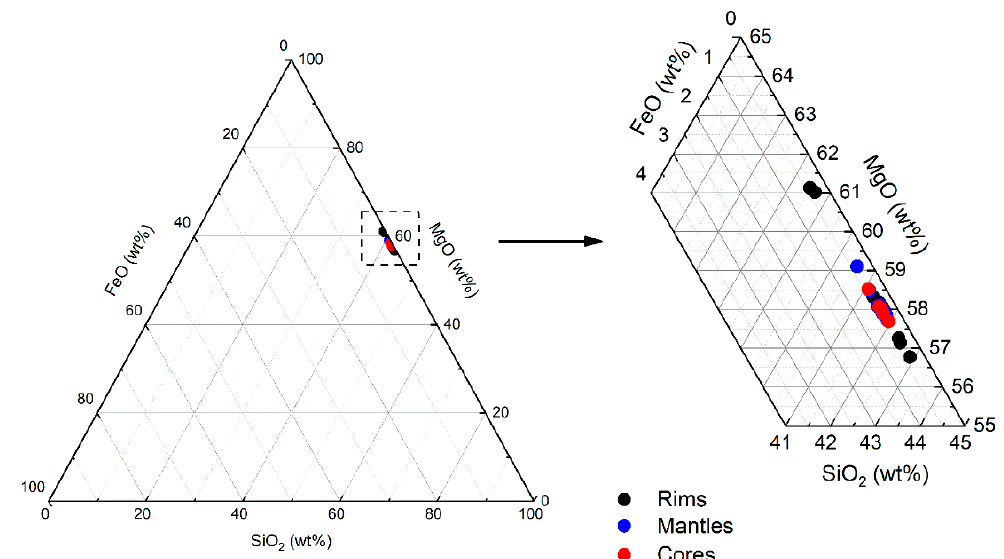
Figure 9. Compositions of the olivines in jianite, plotted in the SiO 2 -MgO-FeO composition triangle